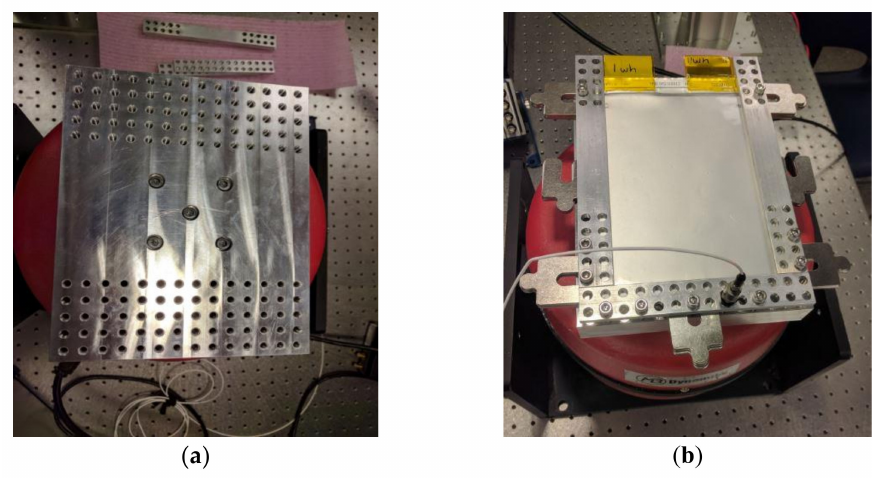
Figure 2. ( a ) Baseplate installed onto the aperture arm of the shaker, ( b ) Complete experimental setup with the pouch LIB.